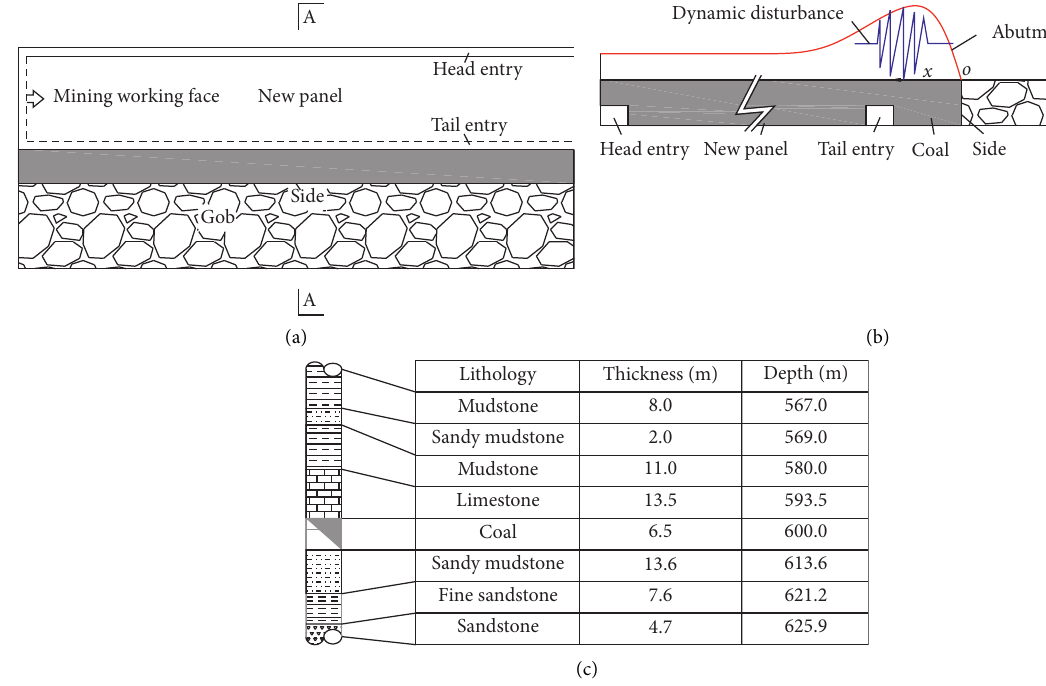
Figure 1: Geological and engineering conditions of the entry. (a) Mining engineering plan; (b) A-A cross section in (a); (c) local drilling histogram. The gob has been in consolidation before the tail entry driving begins. The tail entry with dimensions of 5.0m in width and 4.0m in height is arranged along the coal floor and it is going to be excavated after its location is